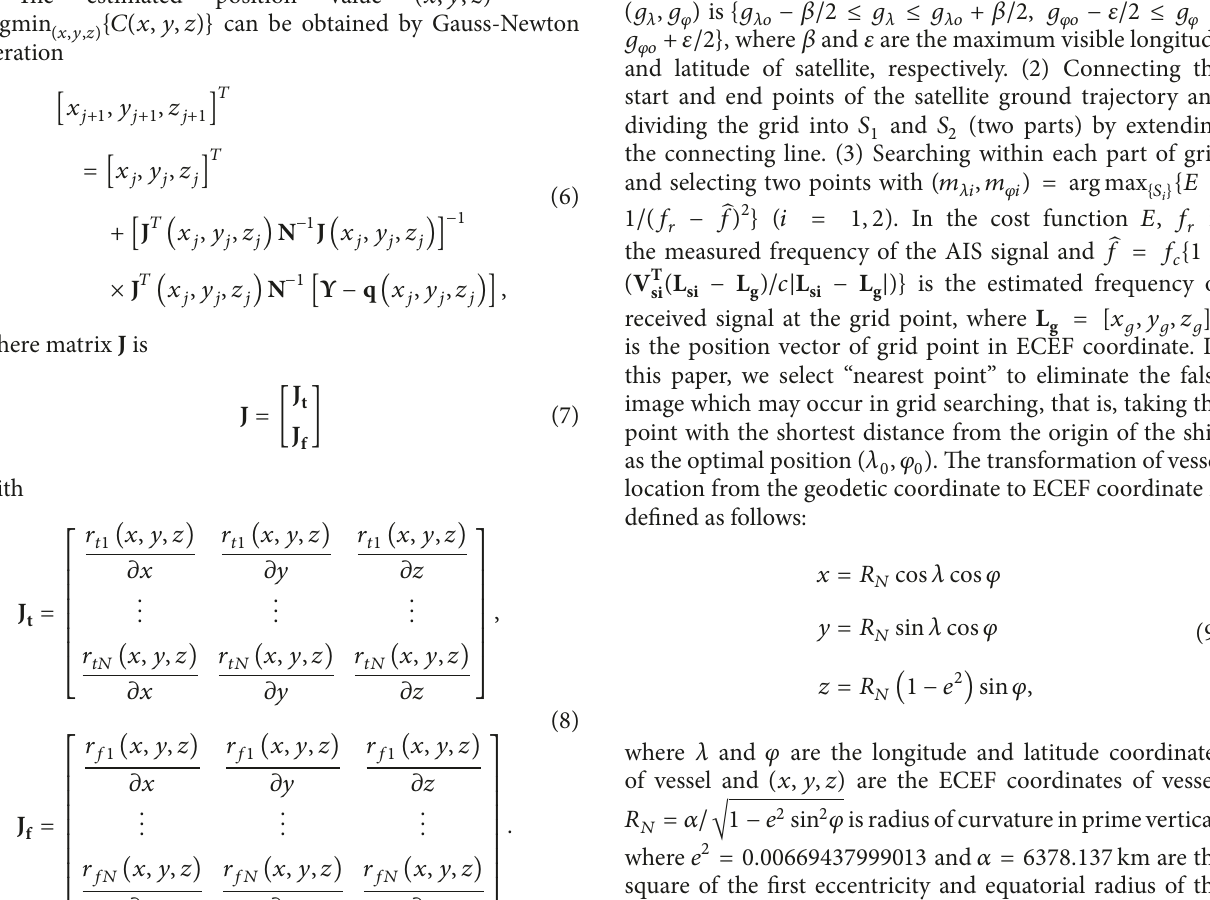
𝑅 = 𝛼/√1 − 𝑒 2 sin 2 𝜑 is radius of curvature in prime vertical, 𝑁 where 𝑒 2 = 0.00669437999013 and 𝛼 = 6378.137 km are the earth defined by WGS-84,